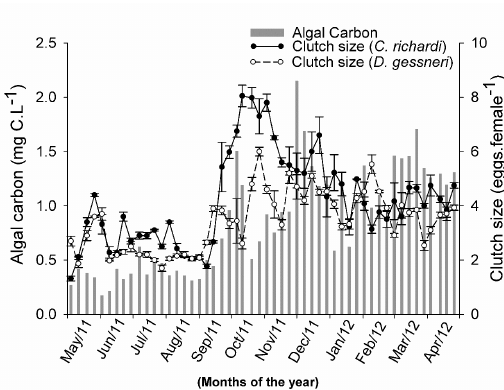
Figure 1. Weekly variation of algal carbon and clutch size of C. richardi and D. gessneri in Lake Monte Alegre, in the period May 2011 to April 2012. Bars are standard error of the means (±) based on three